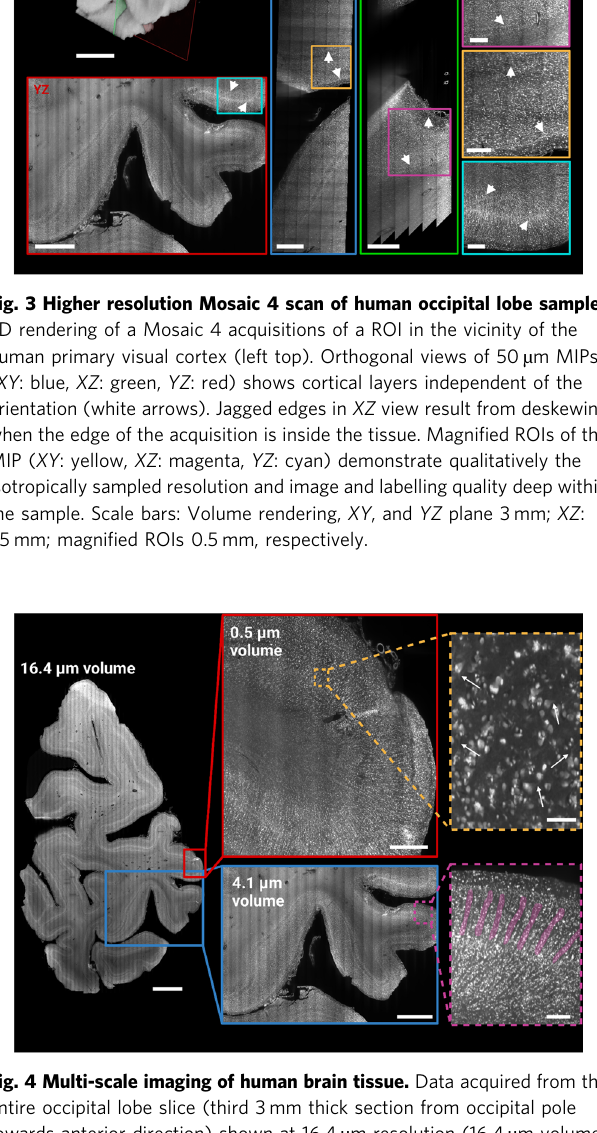
V1/V2 border is visible at this mesoscopic resolution as a clear change in layer patterning (Fig. 1, black arrows).